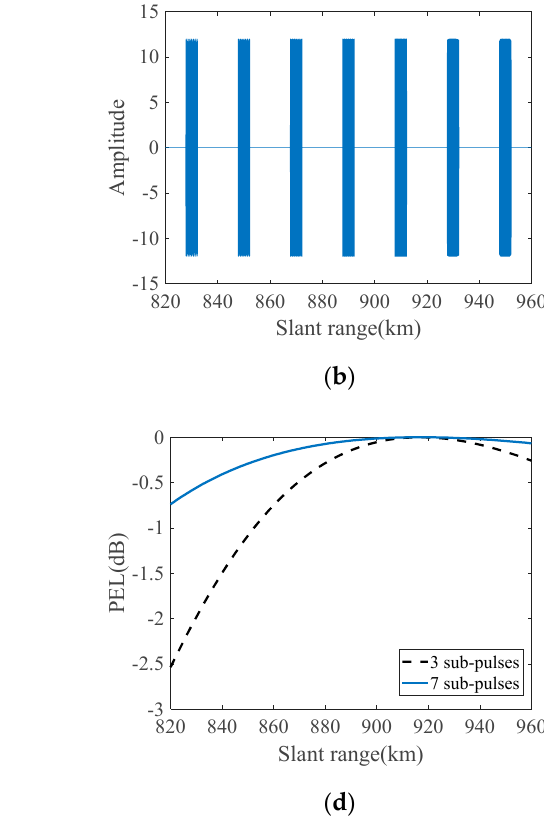
Figure 7. Processing results of signals processed by the improved DBF processor with multi-frequency time delays. ( a ) Real part of echoes with 3 sub-pulses. ( b ) Real part of echoes with 7 sub-pulses. ( c ) Residual PEL in ( a , d ). Residual PEL in ( a , b ).